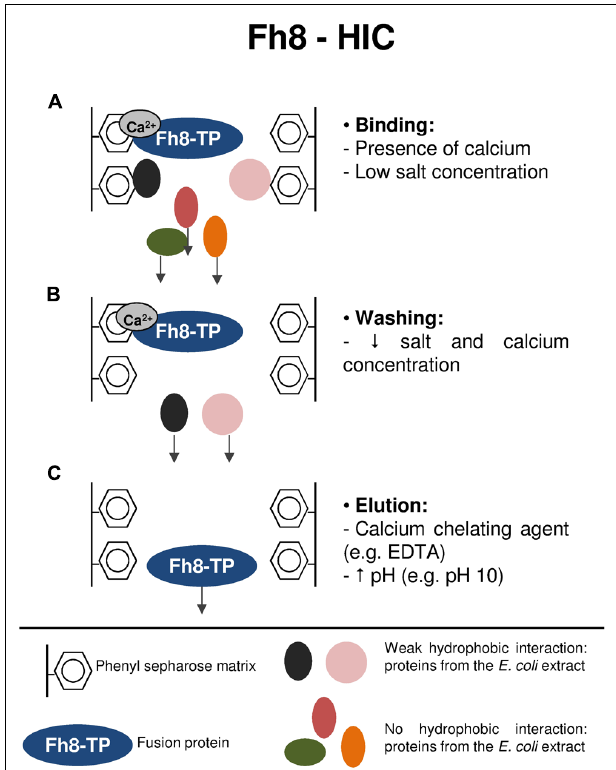
FIGURE 3 | Protein purification strategy using the Fh8-HIC methodology. (A) Binding step: the Fh8-fused protein interacts with the hydrophobic matrix in the presence of calcium and at low salt concentration.This initial binding condition decreases the unspecific binding of other proteins from the E. coli extracts, which leave the column in the flow-through sample. (B) Washing step: by lowering the salts and calcium concentration, weakly interacting contaminant proteins are washed-out, and the Fh8-fused protein remains attached to the hydrophobic matrix. (C) Elution step: a calcium chelating agent, as for instance EDTA, will interfere in the calcium-dependent binding of the Fh8-fused protein, resulting in its elution from the hydrophobic matrix.The Fh8-fused protein can also be eluted by an alternative method: increasing the pH of the elution buffer to 10.This rise in the pH will promote a net charge around the fusion protein, which destabilizes the hydrophobic interactions and results in the elution of the fusion protein.